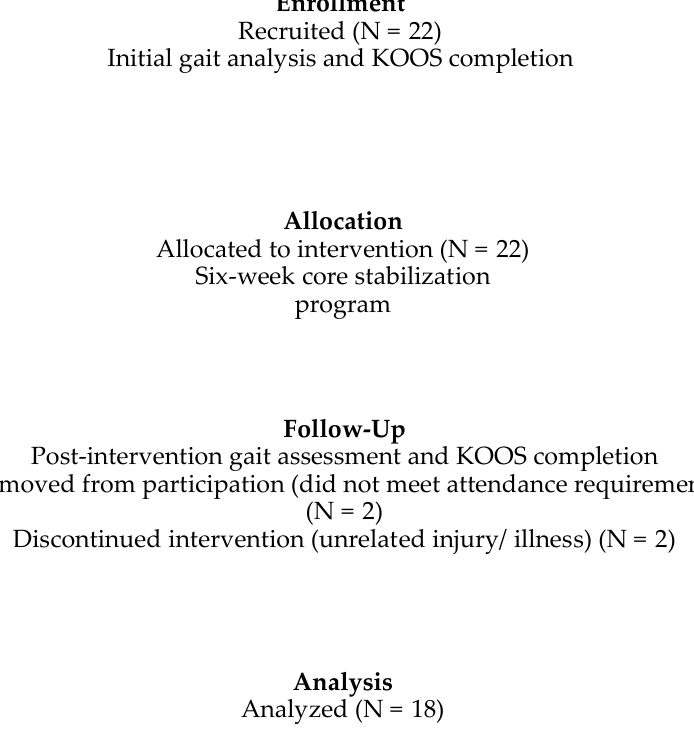
Figure 1. Study Figure 1. Study flowchart. Table 1. Descriptive data for participants.